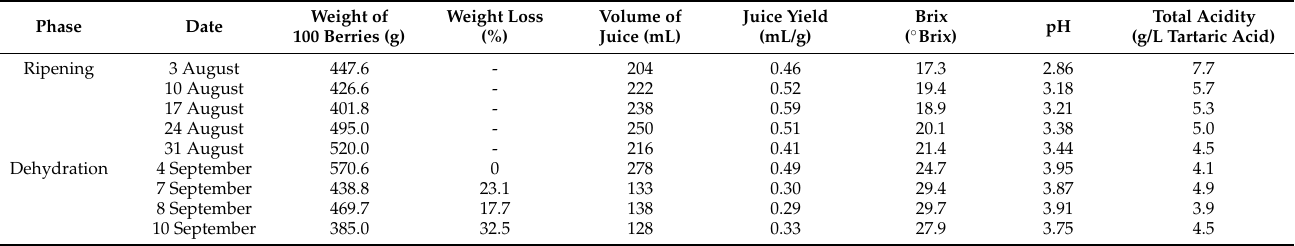
Table 2. Muscat grape berry ripening and dehydration during the 2020